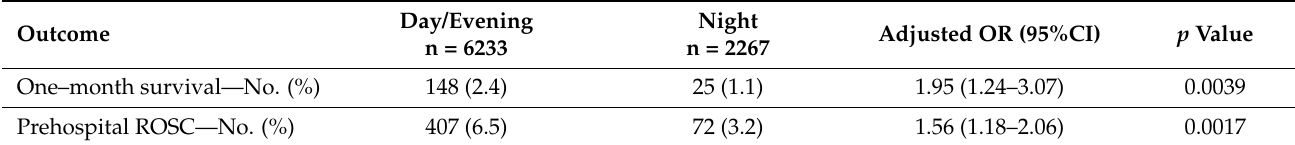
Table 2. Outcomes for traumatic OHCA during the day/evening vs.